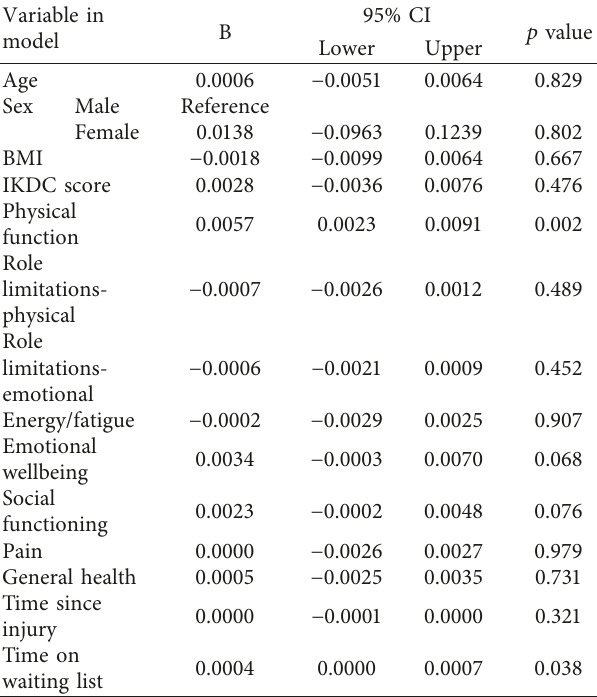
Table 3: Patient variables associated with the EQ-5D 5L score when adjusting for confounding using regression analysis for those awaiting ACL reconstruction ( R 2 0.66). (cid:31)